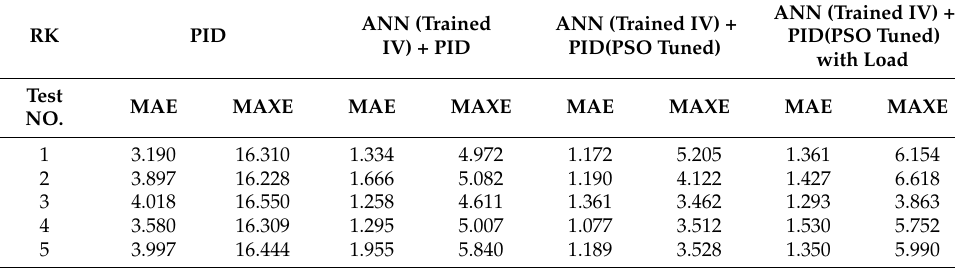
Table 6. Comparison table of tracking outcomes of different controller (right knee).